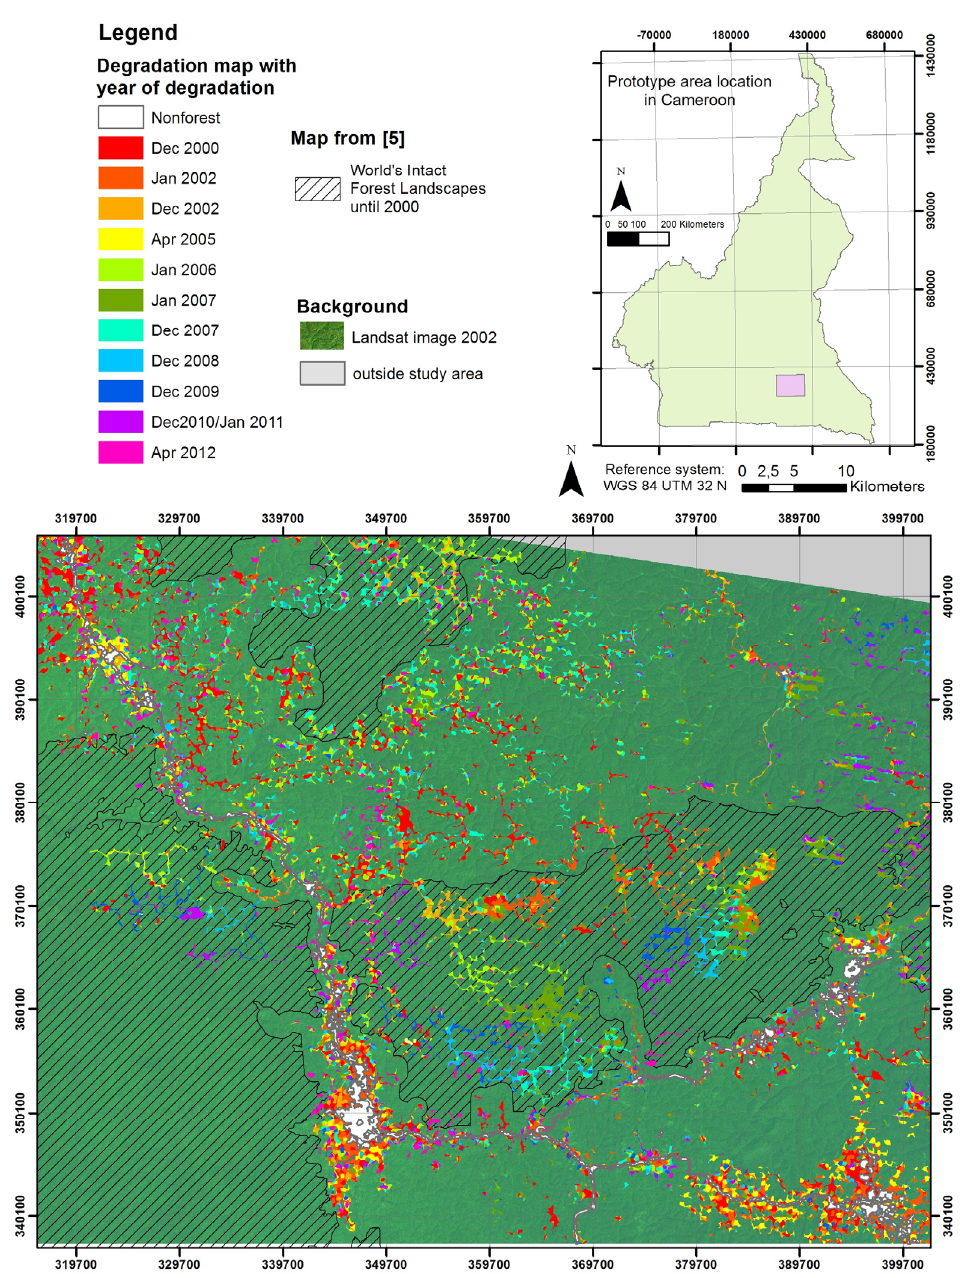
Figure 8. Final degradation map for the Cameroon study site in comparison with the IFL map [5]. The different colors indicate the time of degradation occurrence mapped by our approach, the black hatched area represent the areas classified as